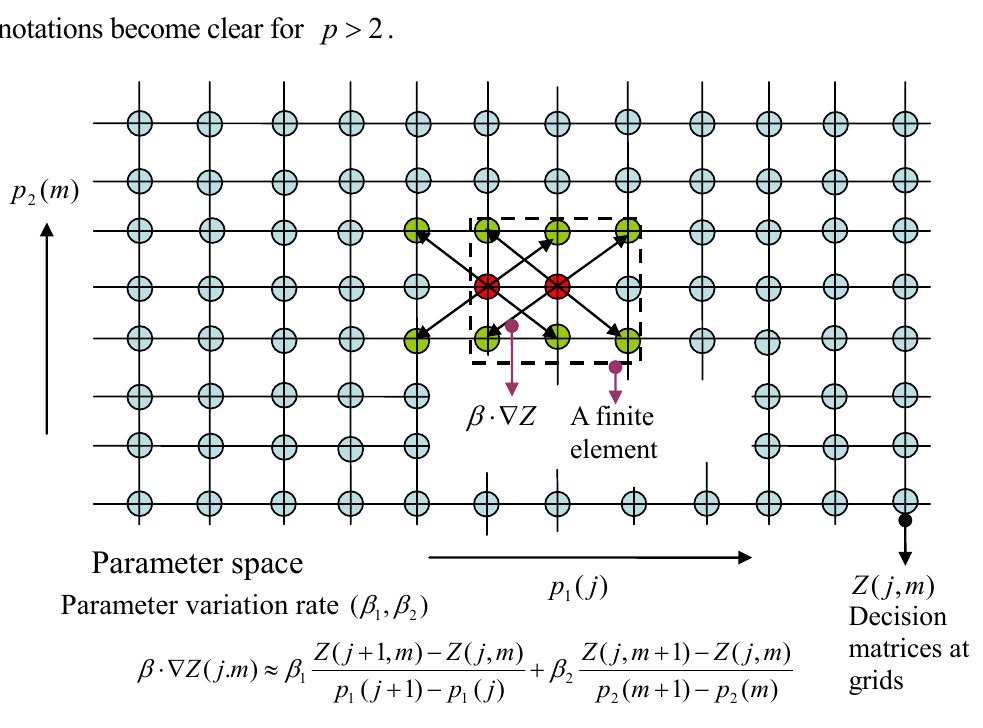
Figure 1. Finite-element approximation of differential linear matrix inequalities